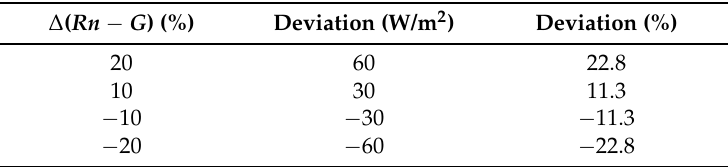
Table 7. Deviations in ET after perturbing Rn ´ G .